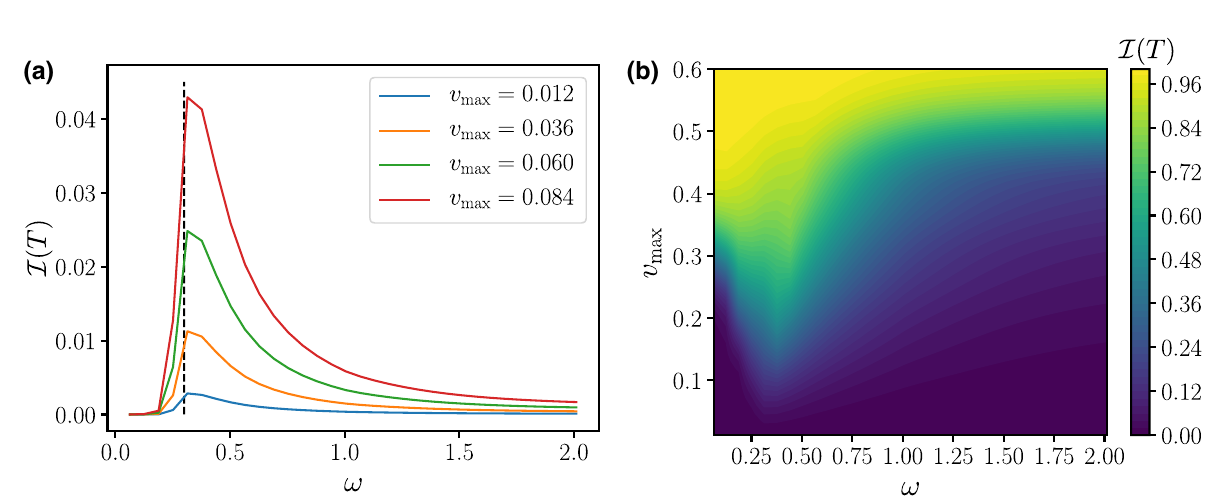
FIG. 10. (a) Infidelity as a function of frequency ω , the black dashed line indicates the resonance frequency ω res = (cid:3) k F = 0.3. At ω (cid:12)→ ∞ the infidelity is the same as for constant linear motion with x v > v = 0.3 there are no low adiabatic frequencies anymore. The parameters used in these simulations are v max . For velocities max crit N = 140, μ = 1, w = 1, (cid:3) = 0.3, and σ =